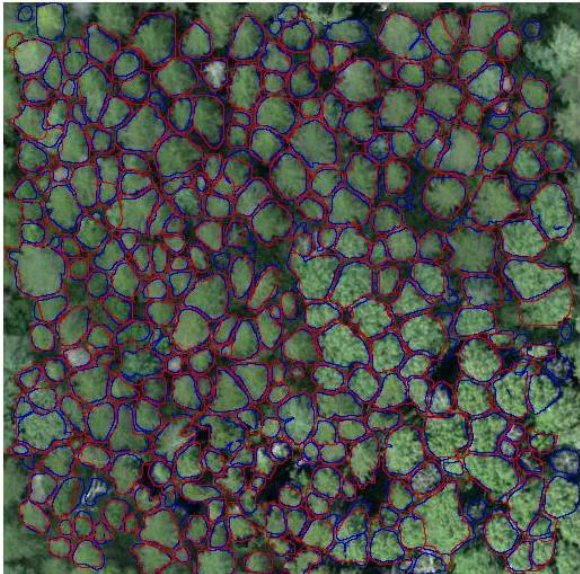
Figure 7 . ITC delineation result (blue circle) generated by Residual U-net, together with the tree crowns manually labelled (red circles) for the test size #1.